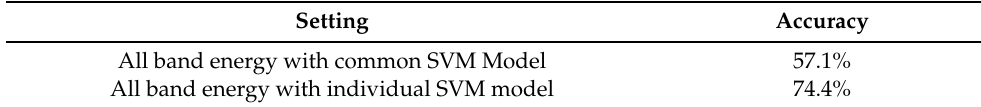
Table 1. Results for experiment I. The numbers given are